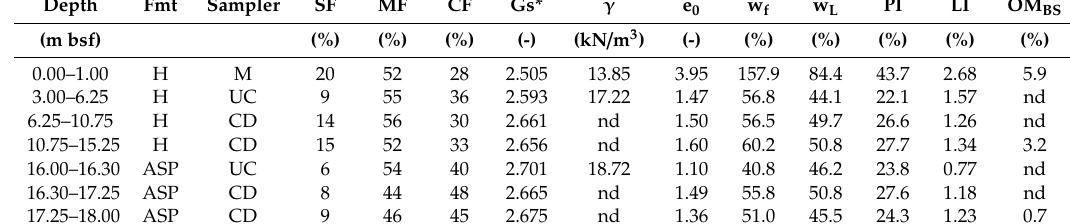
Table 3. Composition and physical properties and geological features of the submarine sediments from borehole A3. Key: H, Holocene sediments; ASP, Sub-Apennine clays; M, manual sampling; UC, undisturbed sampling; CD, core drilling; SF, sand fraction; MF, silt fraction; CF, clay fraction; G* s specific gravity of soil solids; γ , total unit weight; e 0 , void ratio; w f , fluid content; w L , liquid limit; PI, plasticity index; LI, liquidity index; OM BS organic matter; nd, not determined. Table 4. Mineralogical composition (weight %) of the bulk sample and in the clay fraction (in parentheses) of the submarine sediments from borehole A3. Key: Qtz, quartz; K-feld, feldspars; Cal, calcite; Dol, dolomite; Hem, hematite; Hal, halite; I/S, illite/smectite; Chl/S, chlorite/smectite; I, illite; Kao, kaolinite; Chl, chlorite [42].